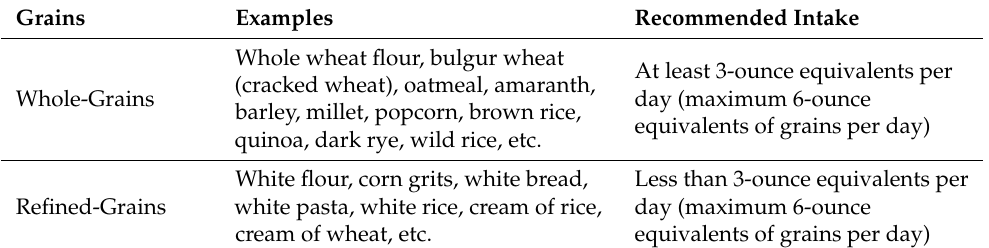
Table 5. MyPlate’s Grain Group and Examples of Whole/Refined Grains with Recommended Intakes